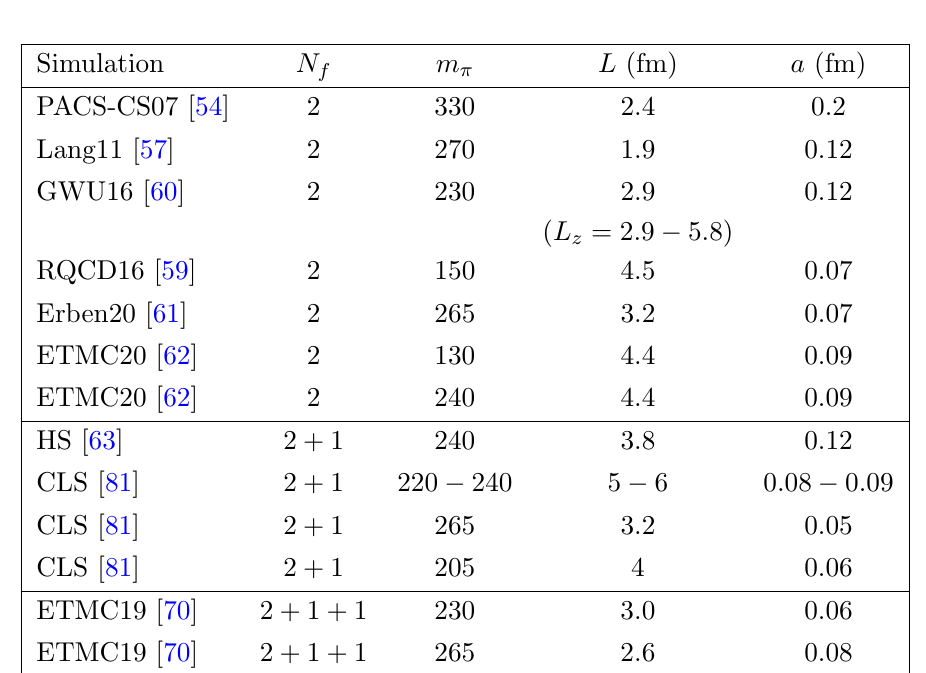
Table 12 . Typical values of the volumes and lattice spacings used for several collaborations in simulations for di(cid:11)erent (cid:13)avors and the lightest pion masses.